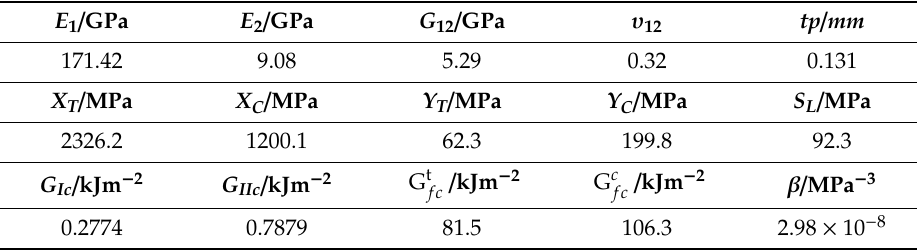
Table 3. Mechanical properties of material IM7 / 8552 [29].